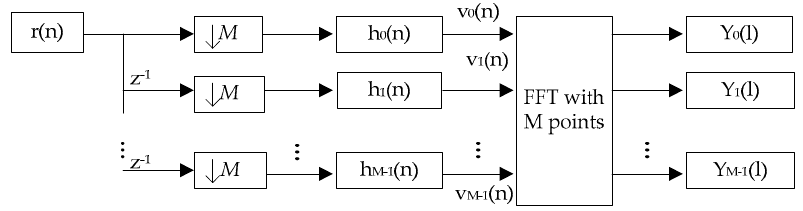
Figure 3. Sub-bands division based on P-DFTFB.